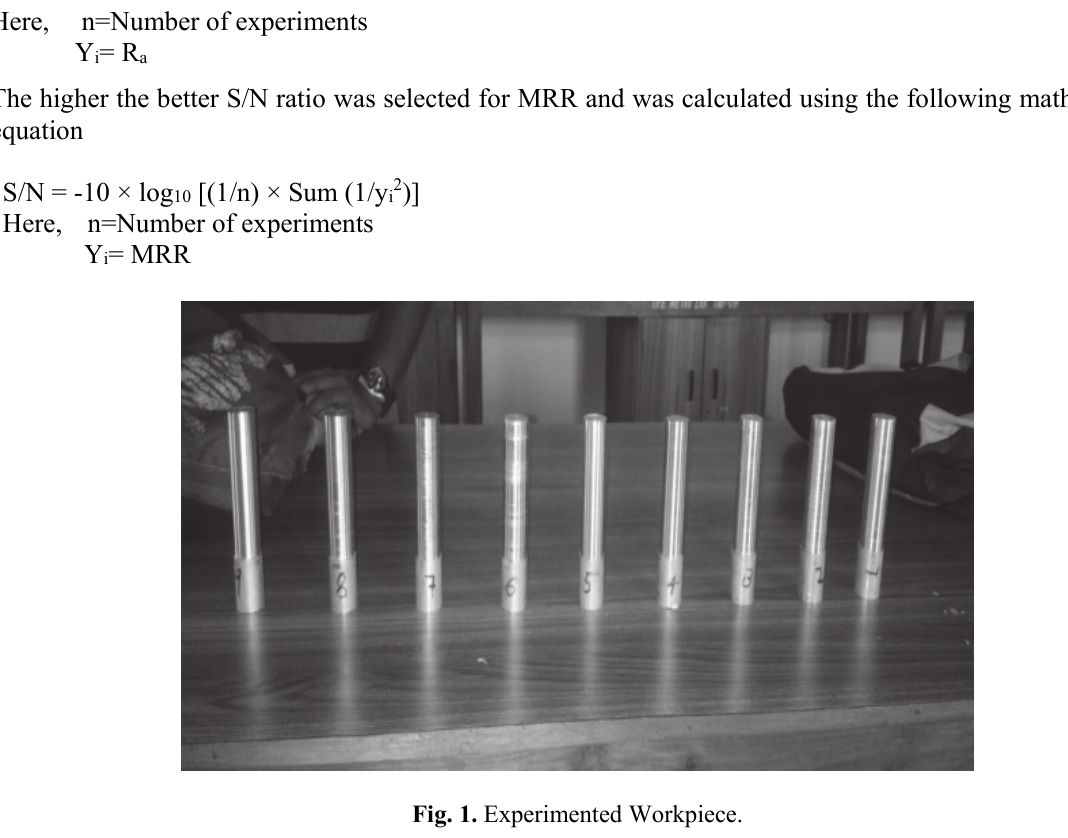
Fig. 1. Experimented